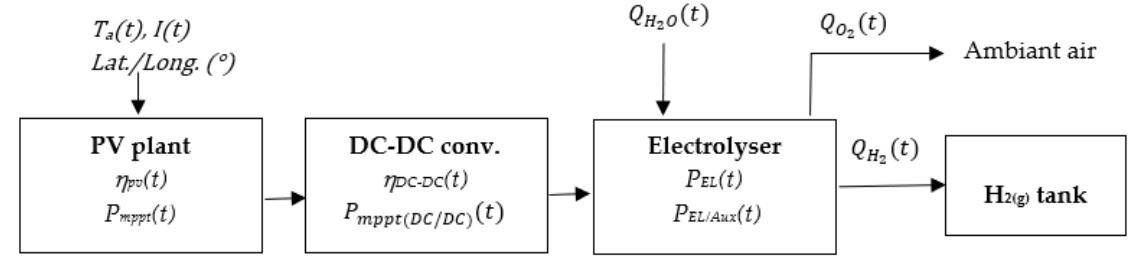
Figure 1. Synoptic of the green H 2(g) production from PV/EL system.